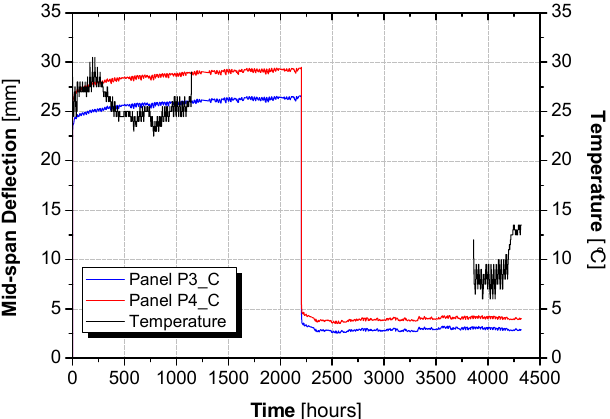
Figure 13. Mid-span displacement variation with time.